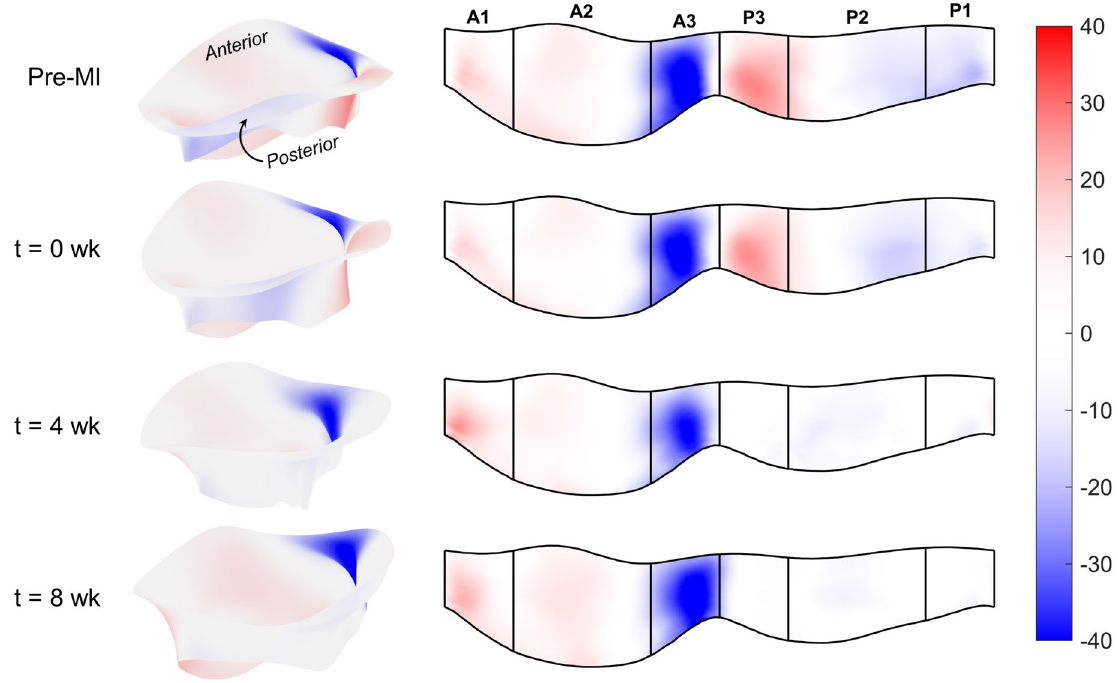
Figure 5. Average systolic shear angle fields over time (in degrees), shown on both the 3D and 2D parametric representations of the leaflet surface. 3D surfaces are shaded for visualisation. Note that by 4 weeks post-MI, the magnitude of shearing in the posterior leaflet becomes negligible. Diastolic shear angle magnitudes were not substantial for any time point (Figure S4), and are thus not shown here (see Supplementary Information for diastolic and systolic shear angle maps in